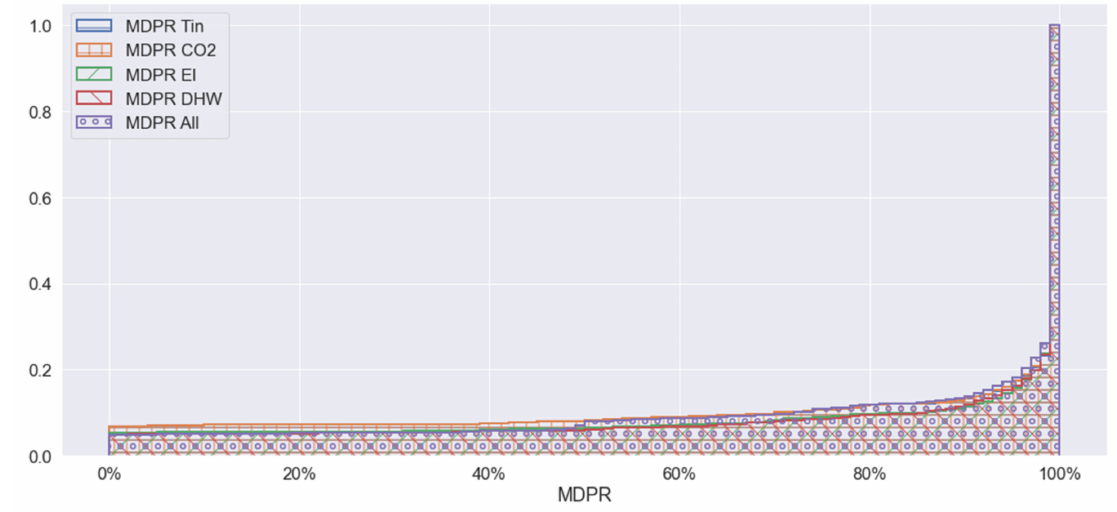
Figure 7. Cumulative MDPR for indoor temperature, CO 2 , electricity and domestic hot water.